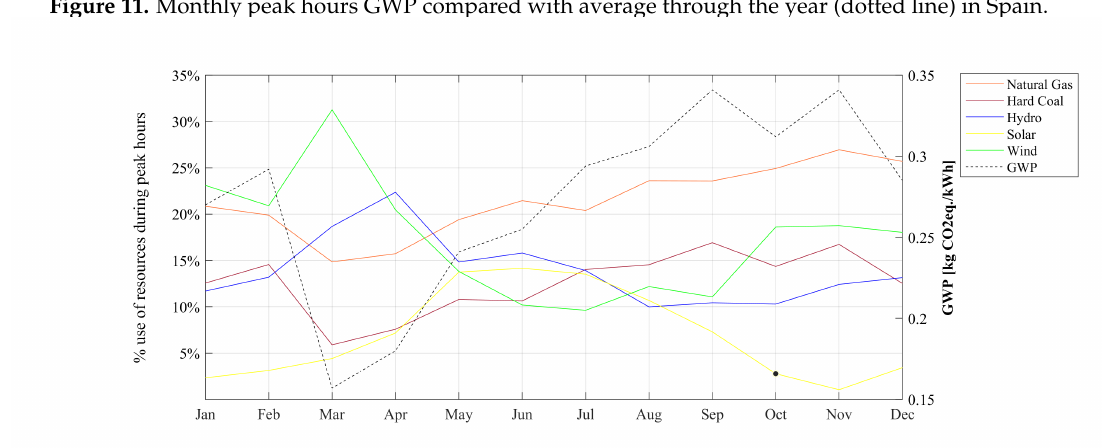
Figure 12. Percentage use of resources throughout the year compared with monthly GWP in Spain (both related to peak